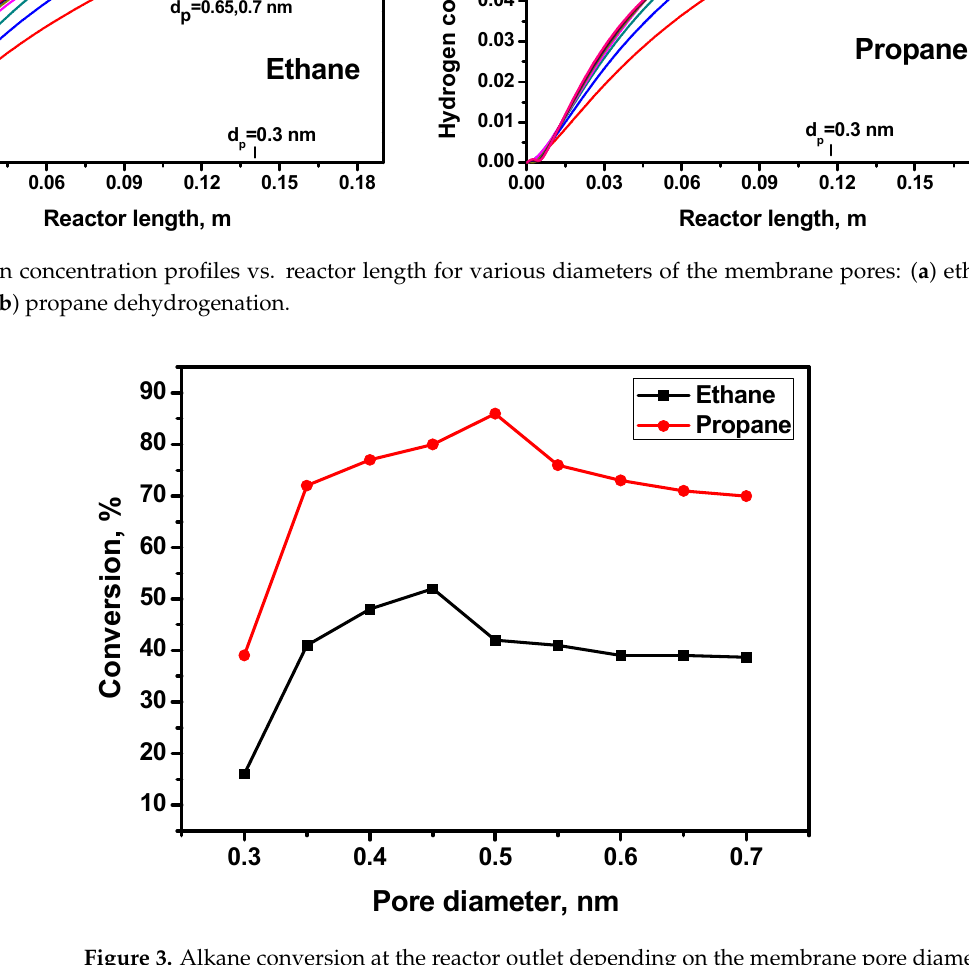
Figure 4. Hydrogen concentrations along the reactor length during the dehydrogenation process in a catalytic membrane reactor ( d p = 0.45 nm) and a tubular reactor: ( a ) ethane dehydrogenation; ( b ) propane dehydrogenation. As seen, the total outlet hydrogen concentration can be significantly improved by performing the dehydrogenation process in CMR. In the case of ethane, this value for CMR exceeds that for TR by a factor of 3.3 (Figure 4a). Dehydrogenation of propane in CMR gives a 2.3 times higher concentration of hydrogen at the reactor outlet if compared with TR. Due to the hydrogen removal from the reaction zone, the equilibrium of the dehydrogenation reaction shifts towards the product side, thus improving the yields of hydrogen and alkene. By comparing the hydrogen profiles for tube and shell sides of the CMR, the hydrogen redistribution along the reactor length can be inferred. Initially, at the beginning of the reaction, hydrogen starts to form according to the dehydrogenation reaction, and its concentration in the tube side exceeds that in the shell side. Then, the